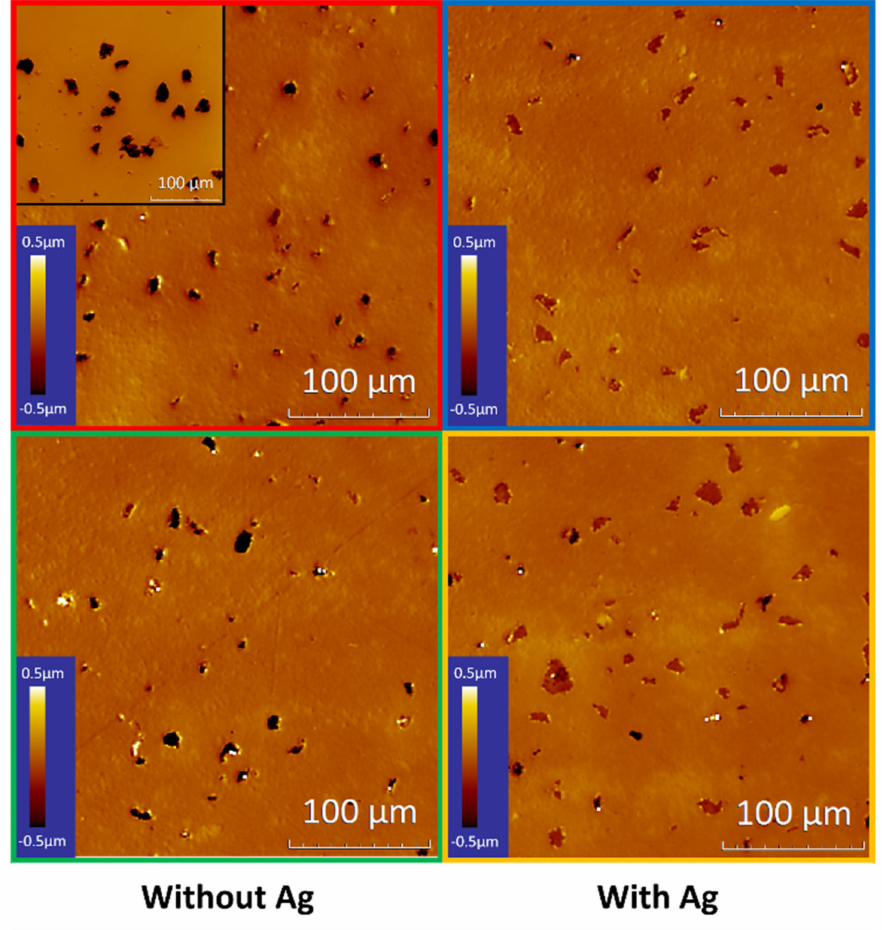
Figure 1. Surface topography of MoN films deposited onto microengineered surfaces obtained by white-light interferometry. The left column displays the MoN surface on top of embossed substrates created with 10 µ m ( top , red ) and 25 µ m ( bottom , green ) stamps. The right column refers to equivalently embossed substrates where the imprints of 10 µ m ( top , blue ) and 25 µ m ( bottom , orange ) were filled with silver before the deposition of MoN. The inset in the top left corner displays the bare substrate after